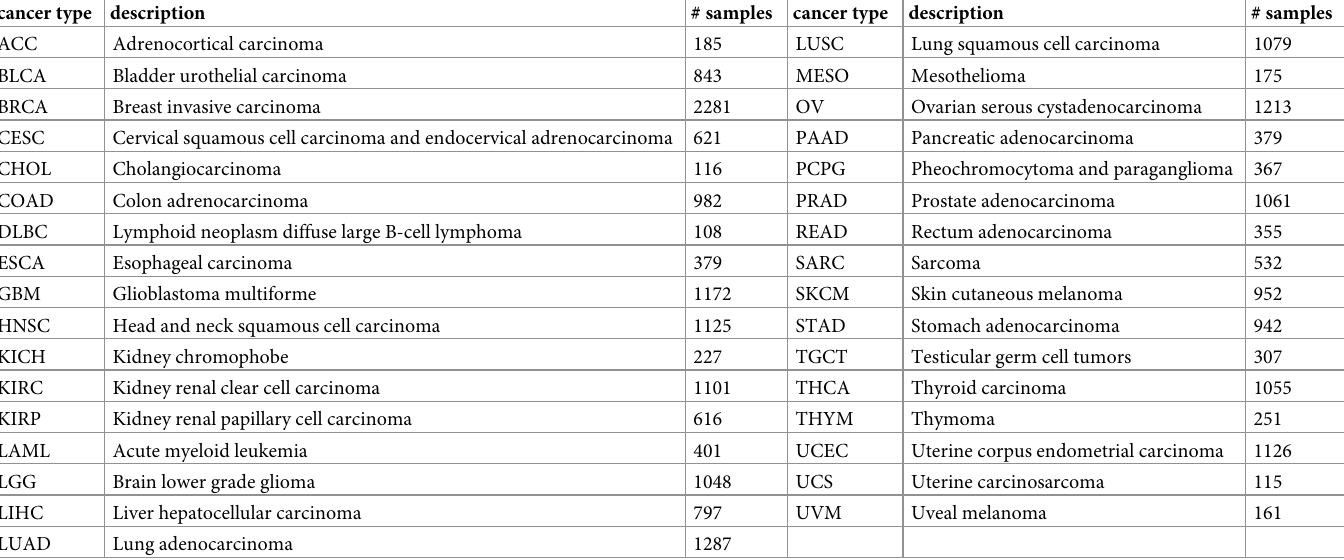
Table 1. 33 cancer types in TCGA data and their sample